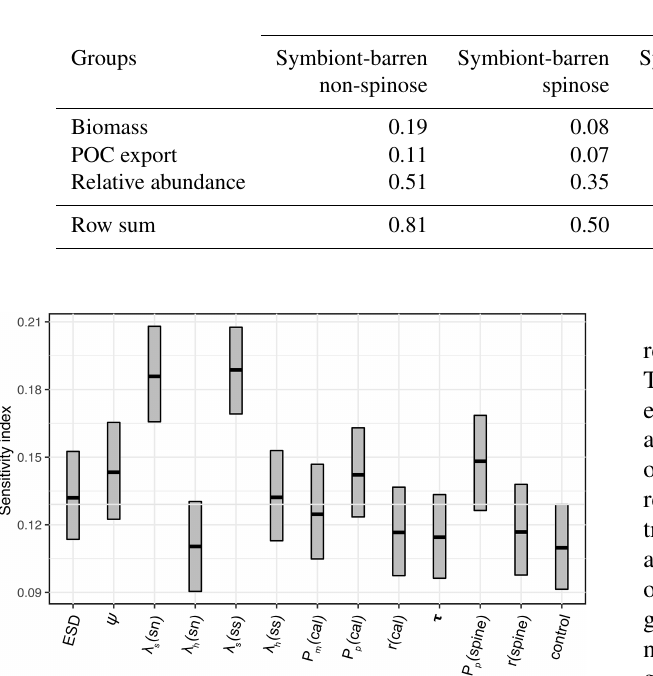
Figure 3. Model parameter sensitivity for overall model perfor- mance (summed M-scores). Bar boundaries indicate the 95% con- fidence interval with the thick line showing the mean value. The grey line indicates the non-influential upper limit of the index value as control group. sn – symbiont-facultative non-spinose; ss – symbiont-bearing spinose. cal – the abbreviation of calcification; τ is the spine effect on grazing